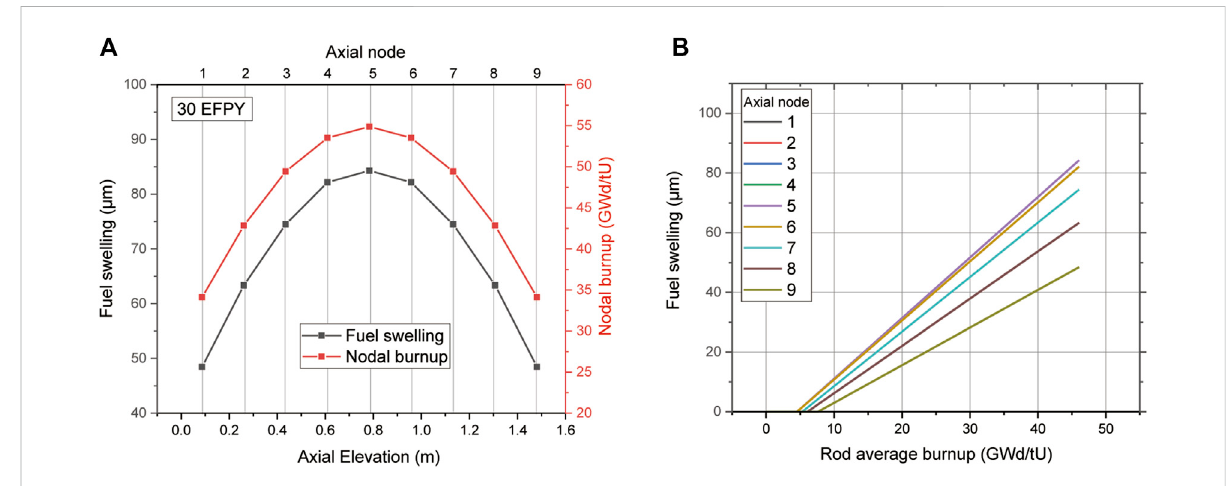
FIGURE 7 Fuel swelling (A) nodal burn-up relationship and (B) rod average burn-up pro fi le.